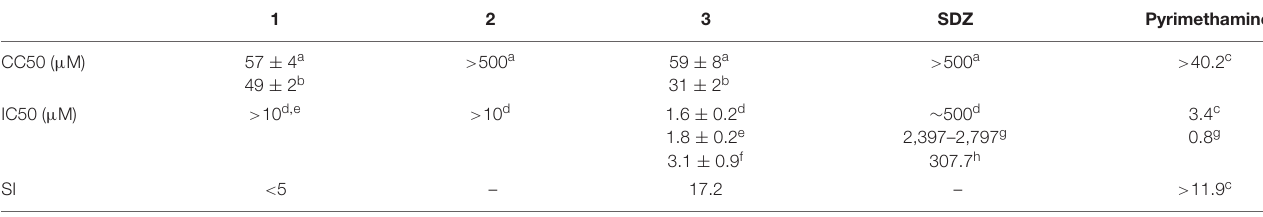
TABLE 1 | Cytotoxicity and anti- T. gondii activity of compounds 1 – 3